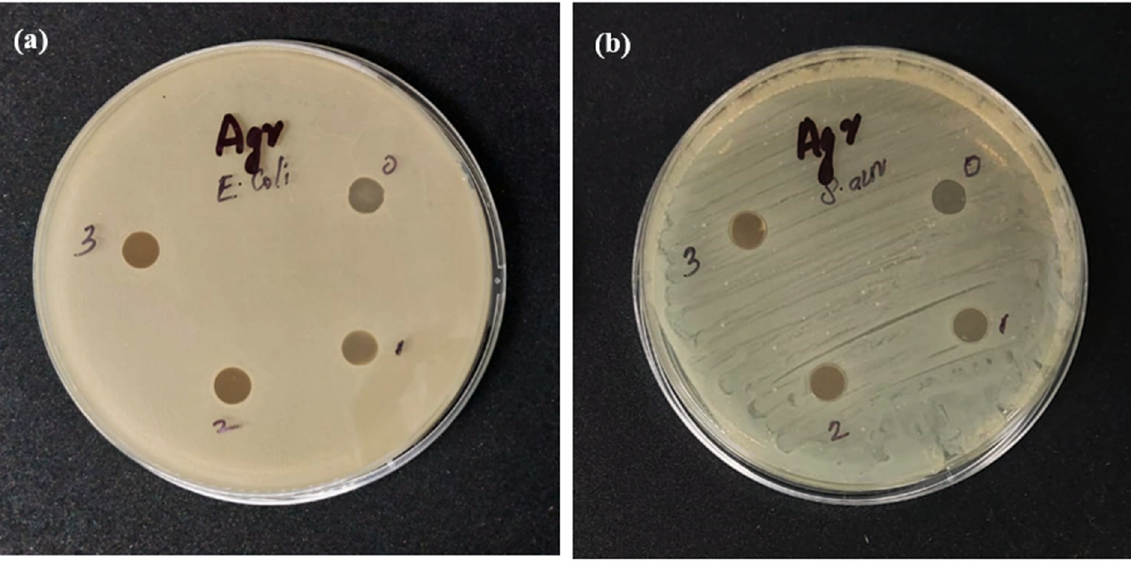
Figure 8. Photograph of antibacterial activity of ZSM-5-loaded biomembrane against ( a ) E. coli and ( b ) S. aureus bacteria : (0) AG-0; (1) AG-1; (2) AG-2; (3) AG-3.